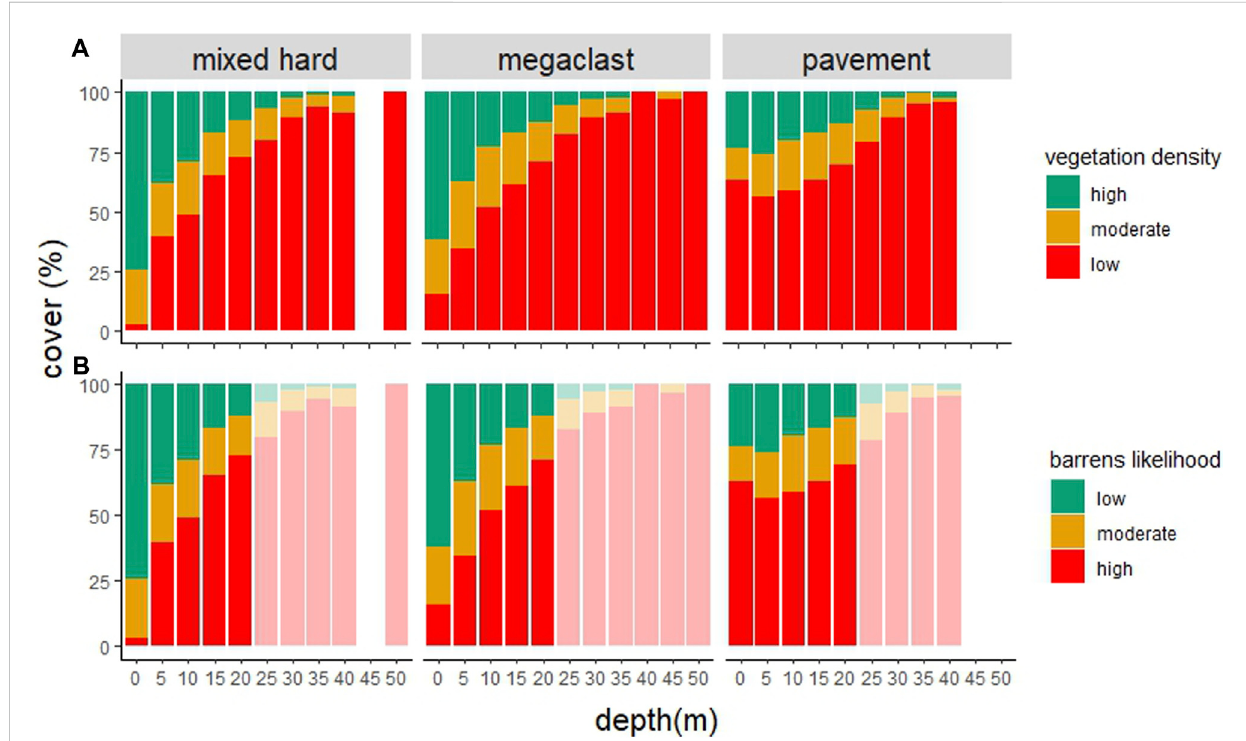
FIGURE 4 Percent cover of (A) different vegetation densities, and (B) inferred barrens likelihood, at different depths (5 m intervals) across different hard substratum types (mixed hard = mixed hard substratum). Lighter shading in b represents depths > 25 m for which vegetation density cannot be used to reliably infer the barrens likelihood.